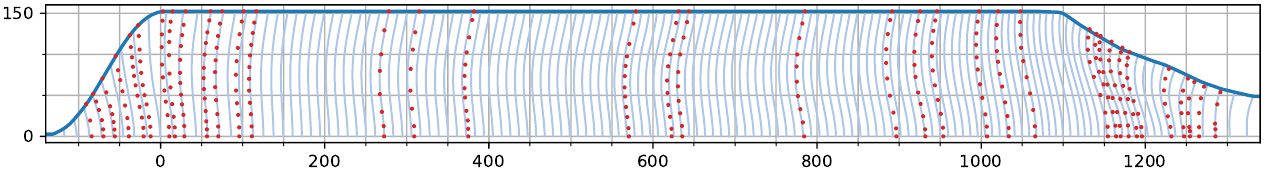
Figure 3. Compilation of the calculated crystallization interface shapes plotted each 20min. Also shown are the interfaces manually extracted from the experimental measurements (red dots). Dimensions are given in